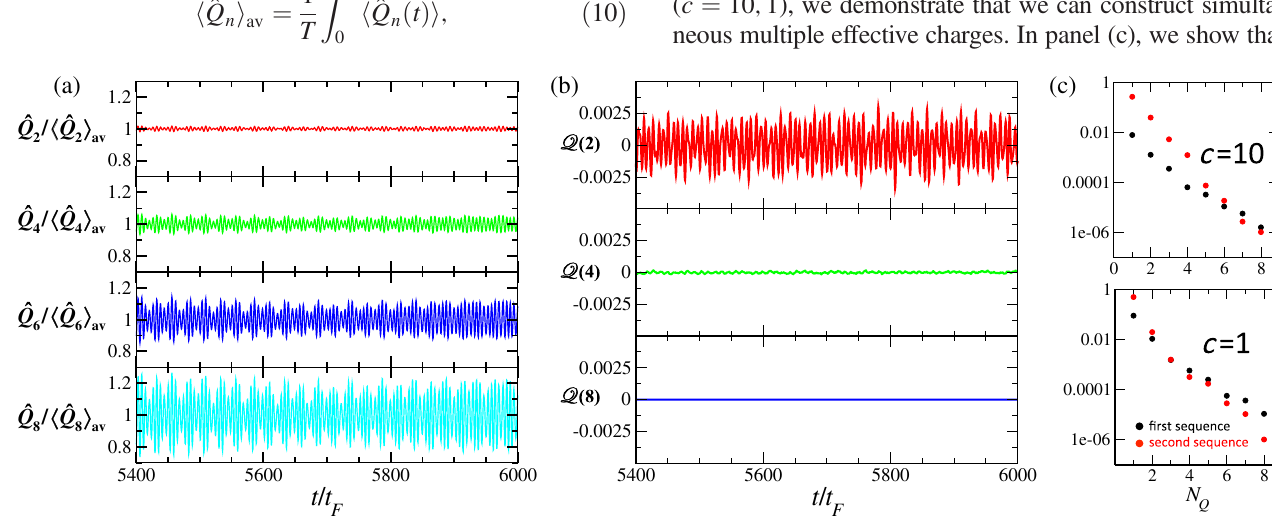
FIG. 3. (a) The post-quench time evolution of the Lieb-Liniger charges normalized by their mean value as described in the text, ˆ Q = h ˆ Q N ¼ L ¼ 8 , c ¼ 10 gas prepared in a parabolic potential of i i i av . Here, the time dependence is computed after releasing an strength m ω 2 0 L 2 = 2 E F ¼ 3 . 24 into a cosine potential cos ½ð 4 π =L Þ x (cid:3) . We show this behavior at late times (for details of how long we can run the simulation, see Appendix A 1). (b) The post-quench time evolution of a sequence of effective charges with the mean subtracted P N Q ˆ Q a N 2 ; 4 , and 8. (c) Top panel: The standard deviation of the fluctuations of two sequences of off, Q ð N Q Þ ¼ 2 m 2 m , for Q ¼ m ¼ 1 effective charges Q . We build the first sequence (in black) using linear combinations of the charges f